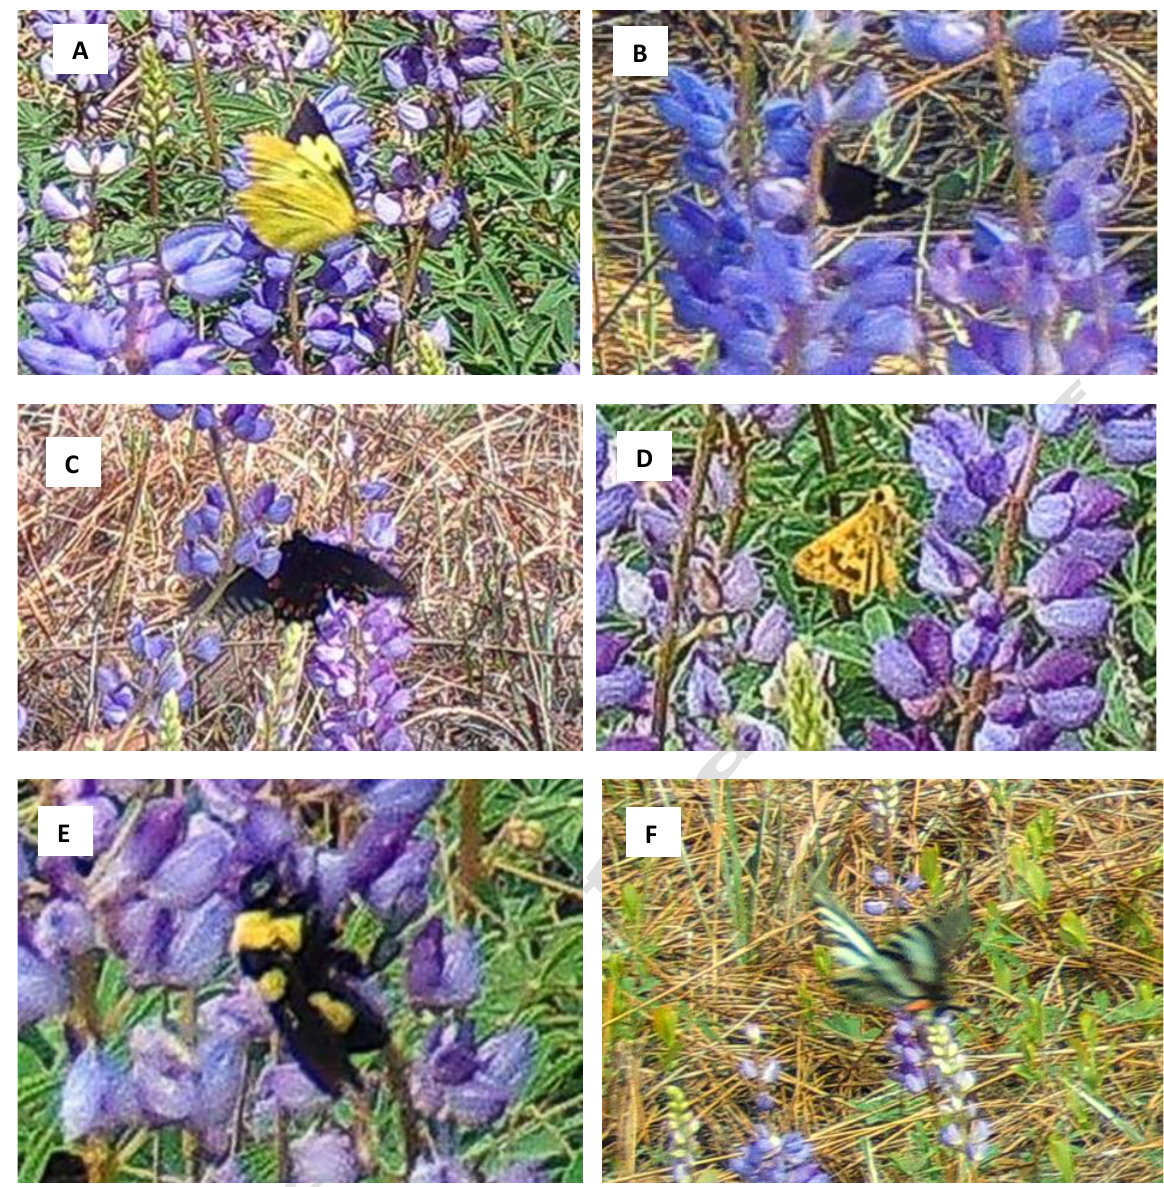
F IGURE 3: Camera trap images taken at sundial lupine (Lupinus perennis) patch: (A) southern dogface (Colias cesonia); (B) cloudywing (Thorybes sp.); (C) pipevine swallowtail (Battus philenor); (D) whirlabout (Polites vibex); (E) bumblebee (Bombus spp.); (F) zebra swallowtail (Eurytides